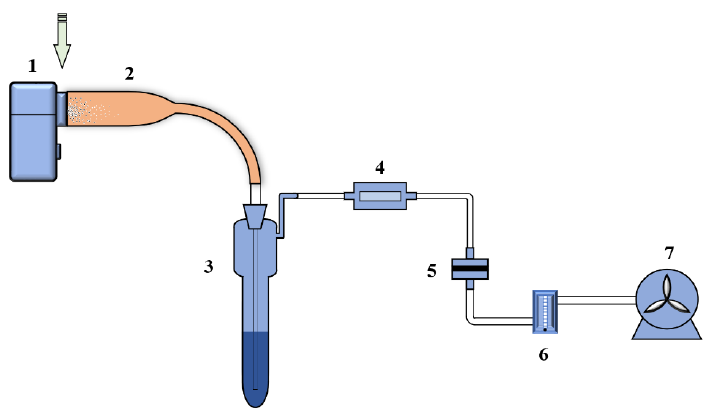
Figure 1. Schematic of experimental setup: (1) VMN, (2) idealized mouth-throat airway model, (3) bubble absorption tube, (4) prefilter, (5) membrane filter, (6) glass rotor flowmeter, (7) vacuum